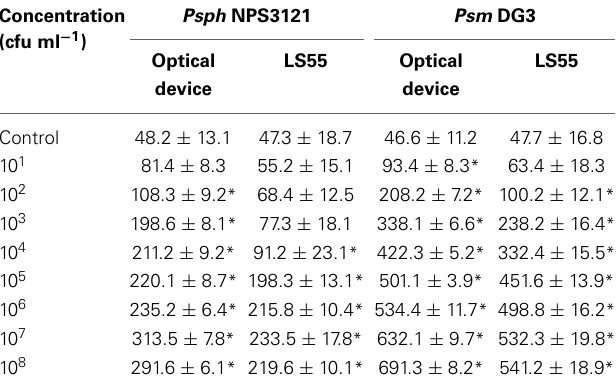
Table 1 | Quantitative analysis of the suitability of the optical device for detecting the ROS production of A. thaliana leaves infected by plant